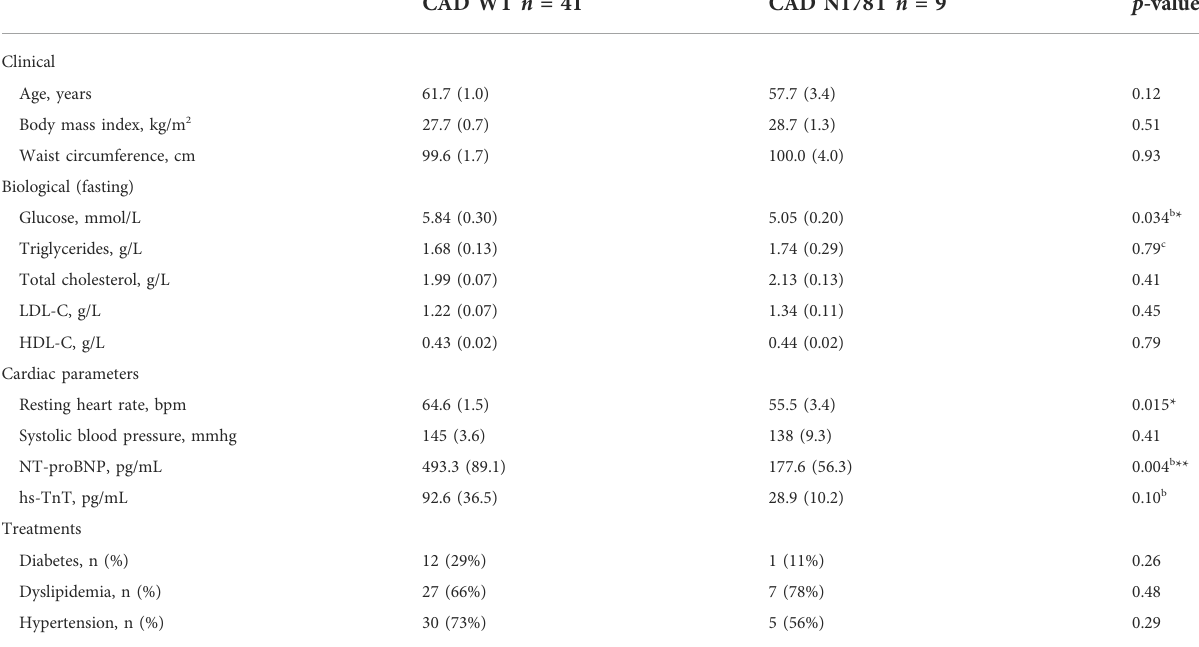
TABLE 4 Baseline characteristics of CAD patients, according to N178T